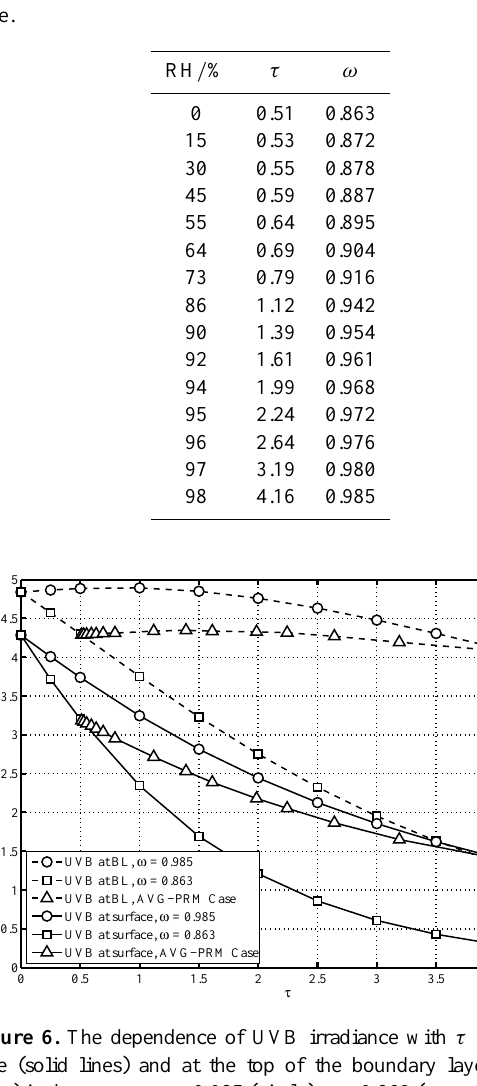
increases by 30.4 % at τ 2